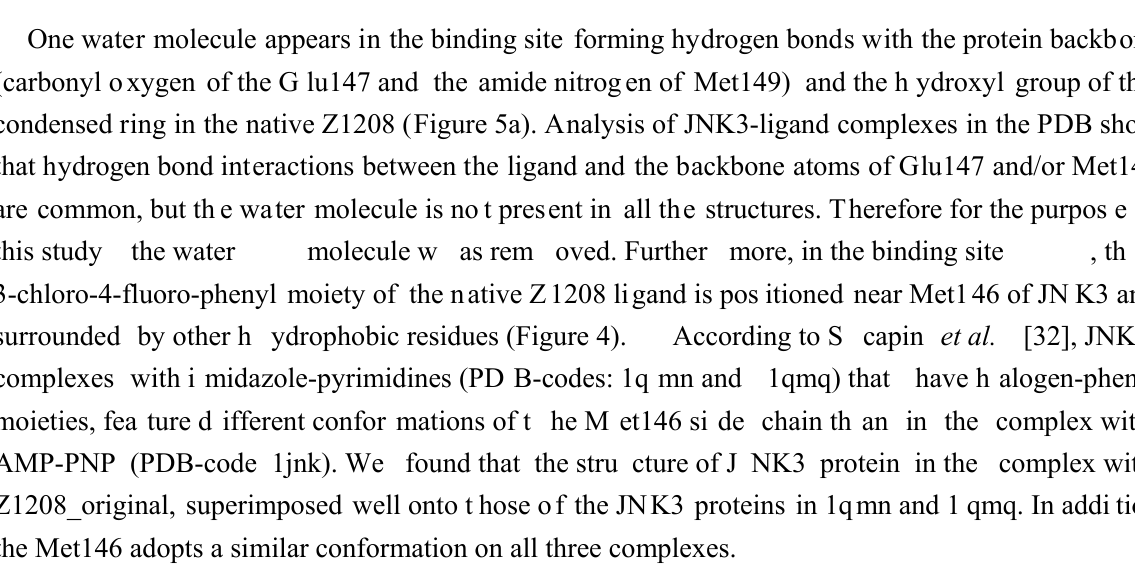
Figure 5. Conformations of (a) native Z1208 and (b) Z1208_8 binding to